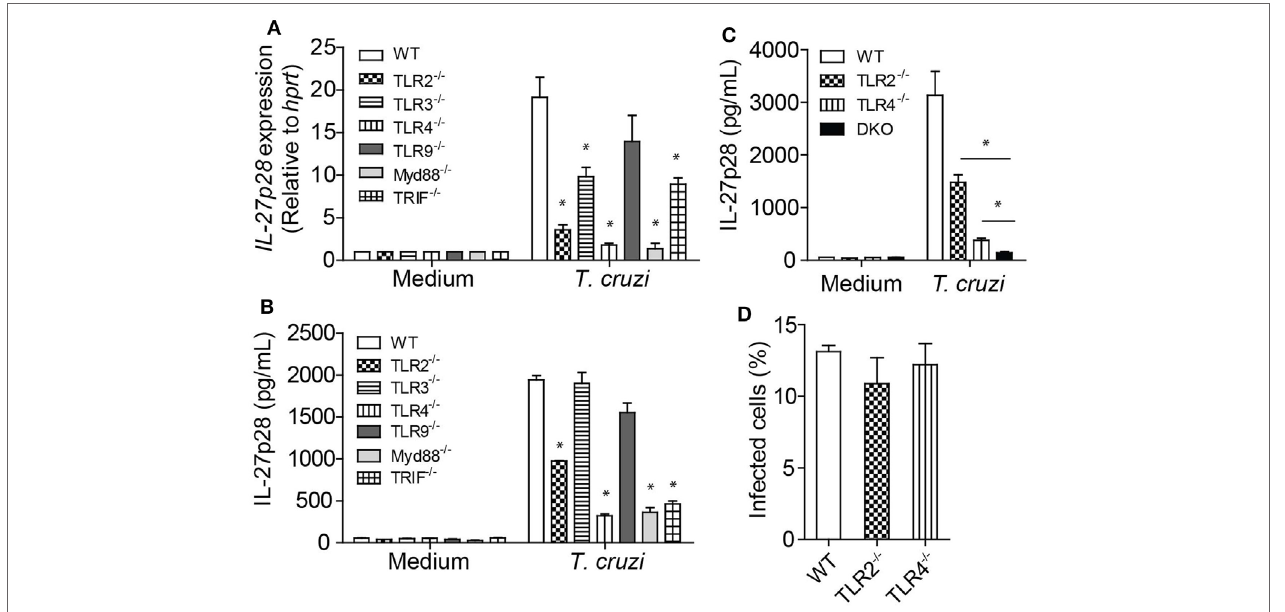
FigUre 5 | Innate immune receptors on macrophages are capable of recognizing Trypanosoma cruzi and induce IL-27p28 production. (a,B) Bone marrow-derived macrophages (BMDM) from wild type (WT) and deficient mice for the molecules Tlr2, Tlr3, Tlr4, Tlr9, MyD88, and Trif were infected with T. cruzi trypomastigotes (MOI 3:1). The mRNA expression of IL-27 was evaluated after 6 h by qPCR as well as the production of IL-27p28 after 48 h by ELISA. Amplified products were normalized in relation to hprt endogenous gene. (c) BMDM from WT and deficient mice for Tlr2 , Tlr4 , or Tlr2/4 double knockout mice were infected with T. cruzi trypomastigotes (MOI 3:1) and the production of IL-27 was evaluated after 48 h by ELISA. (D) BMDM from WT and deficient mice for Tlr2 or Tlr4 were infected with T. cruzi trypomastigotes (MOI 3:1) and, after 4 h, the macrophages were fixed and colored with panotico rápido ® and the percentage of infected cells was measure. Results are representative of three independent experiments performed in quintuplicate. Data are expressed as mean ± SEM * ( P < 0.05) compared to WT